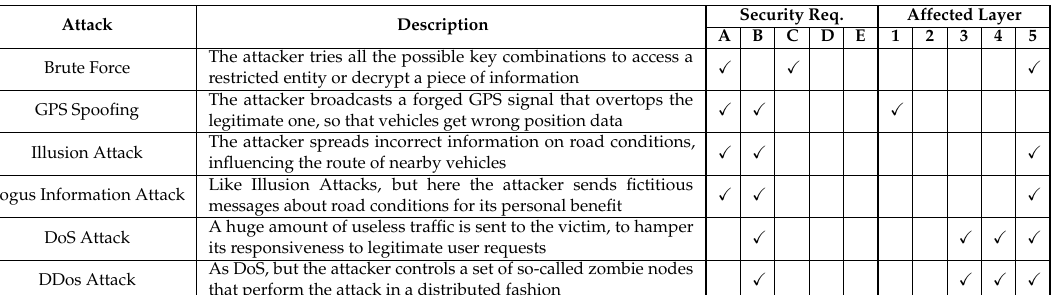
Table 1. Non-exhaustive list of attacks in VANETs, classified by affected TCP/IP Layer, from 1 (PHY) to 5 (APP), and threatened Security Requirement (Security Req.): Authenticity (A), Availability (B), Confidentiality (C), Data Integrity (D), and Non-Repudiation